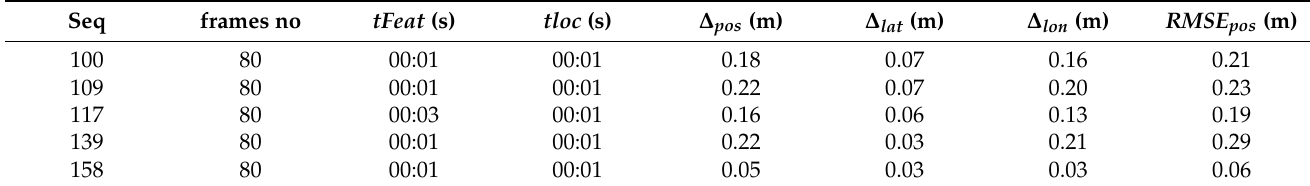
Table 4. Accuracy evaluation of our method in the Pandaset dataset.